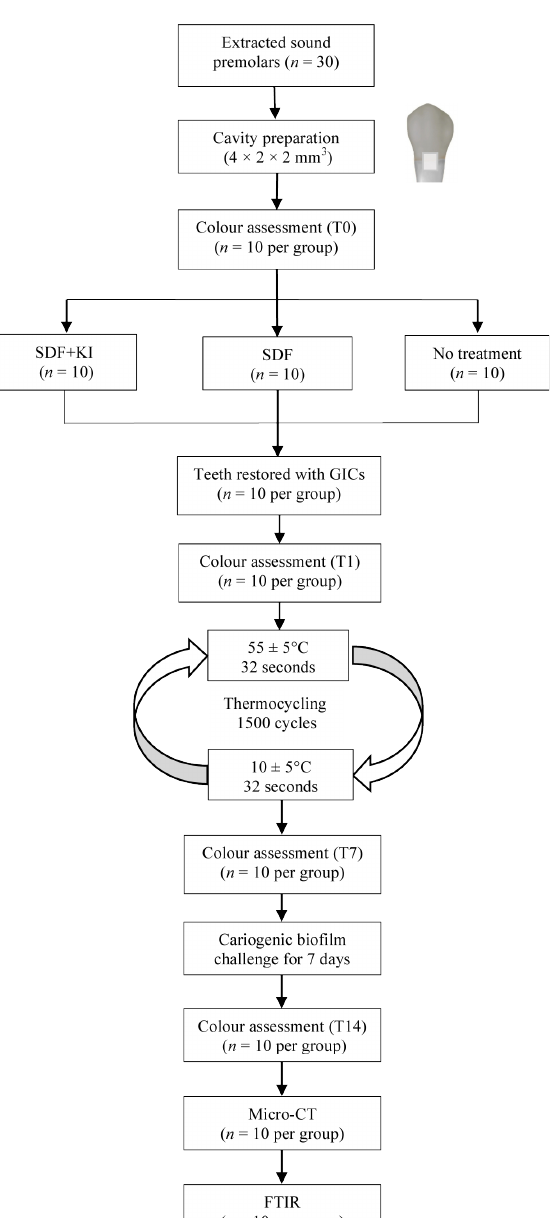
Figure 4. Flow chart of the